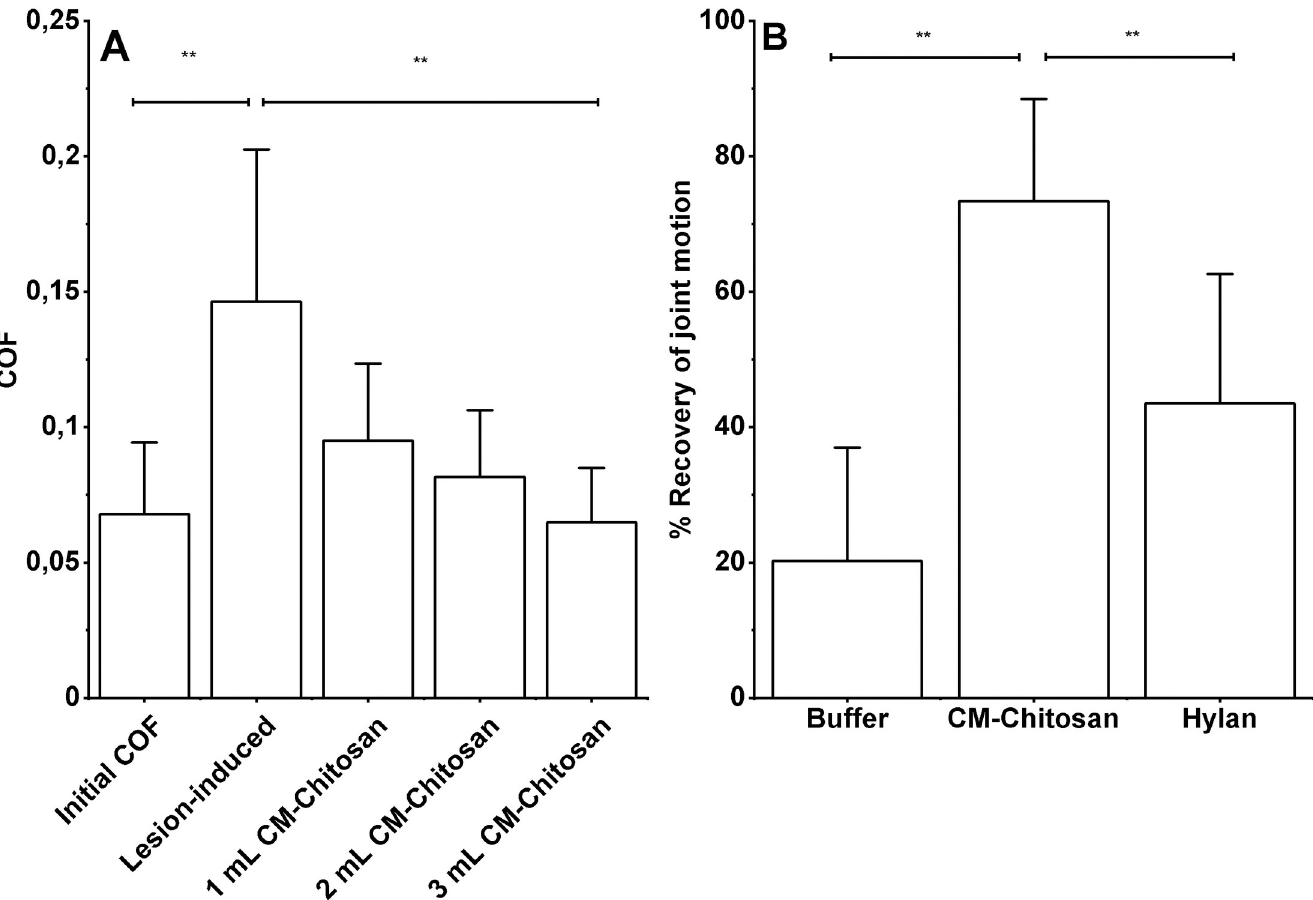
Fig 6. Lubrication capacity of KiOmedine 1 CM-chitosan in the biomechanical ex-vivo sheep model of 3D joint mobility. (A) A significant increase in COF is observed due to increased joint friction in damaged cartilage (paired T-test, �� p < 0.01); COF is then progressively significantly improved following the IA injection with KiOmedine 1 CM-chitosan in a volume-dependent manner (ANOVA, �� p < 0.01). (B) KiOmedine 1 CM-chitosan was compared to Hylan G-F 20 at 3 ml IA volume and showed significantly better recovery of joint motion loss on damaged cartilage (t-test, �� p < 0.01); the effect of the polymer-free buffer of KiOmedine 1 on the recovery of motion was